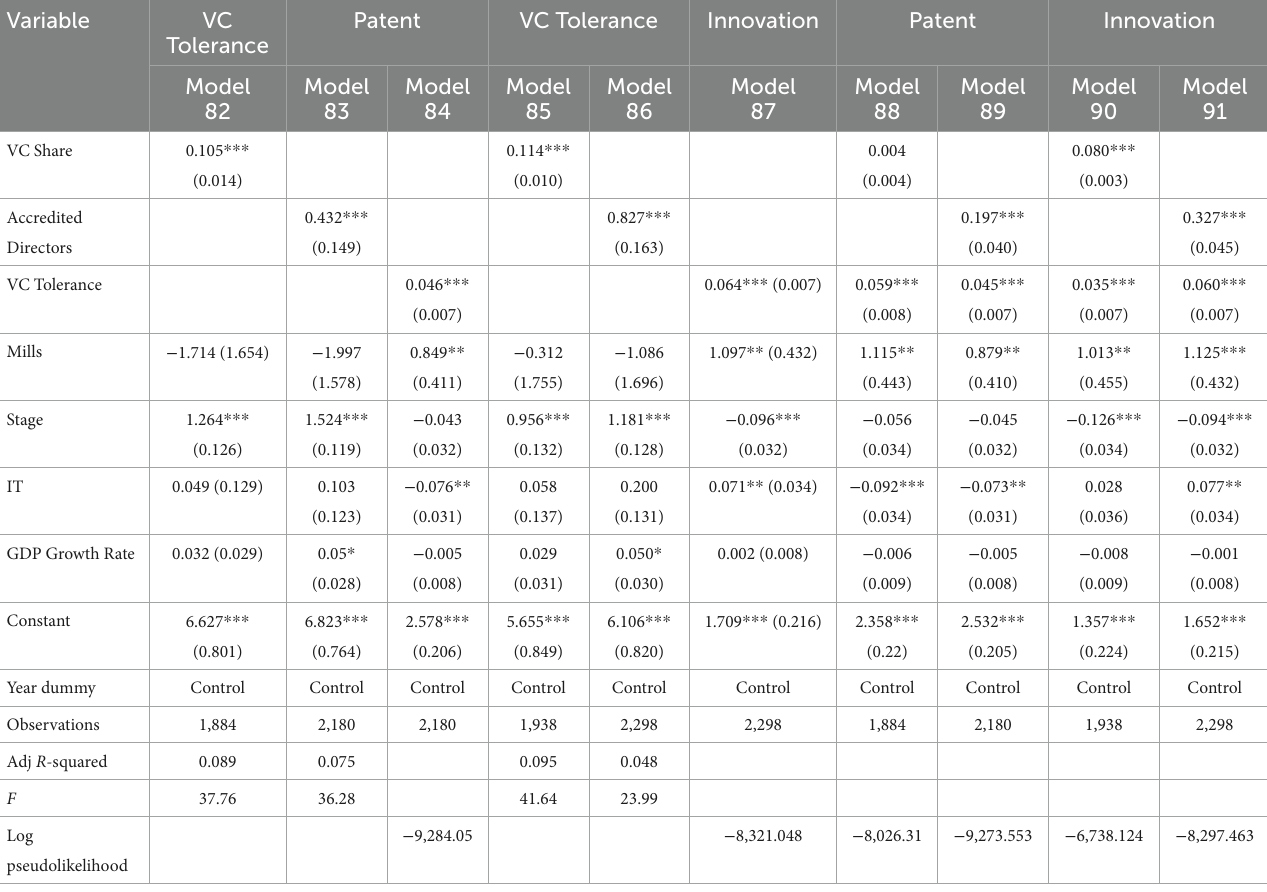
TABLE 15 Heckman treatment effect of VC’s shareholding, dispatching directors and tolerance of failure on enterprise innovation performance (Phase